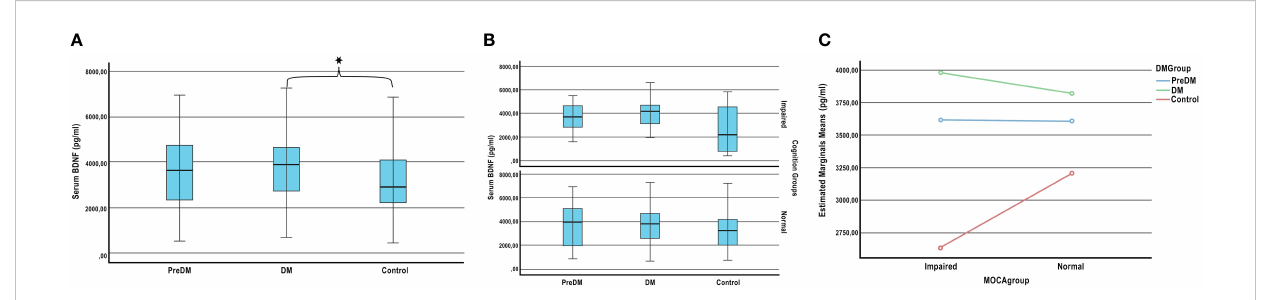
FIGURE 1 Plasma BDNF levels according to the stages of the diabetes and cognition. (A) Comparison of BDNF levels between diabetes group. (B) Comparison of BDNF levels between diabetes and cognitive groups. (C) Effect of diabetes on plasma BDNF levels according to cognitive stages. ANCOVA adjusted for age, sex, and education; * P < 0.05.